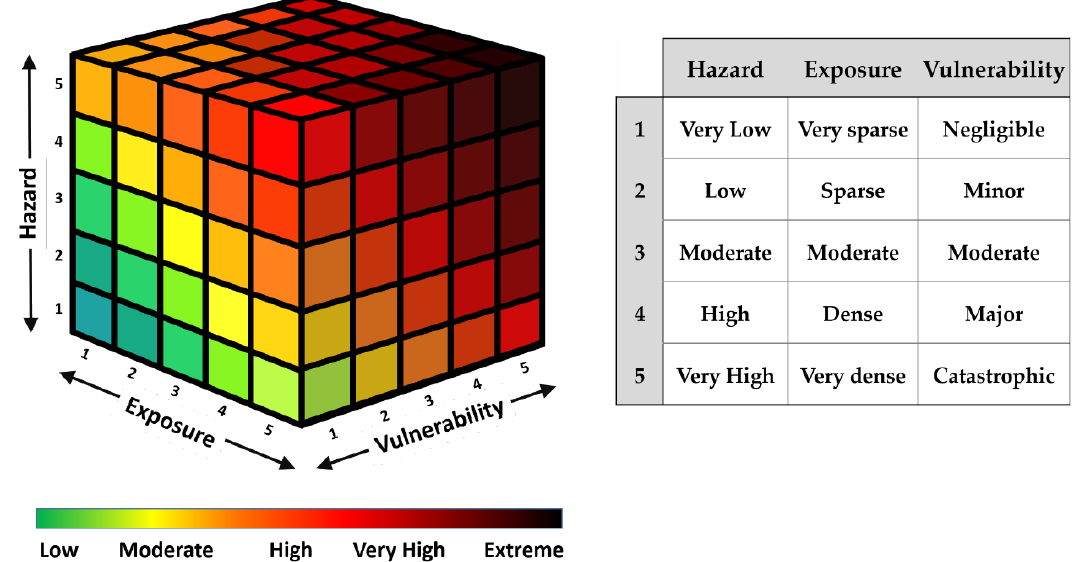
Figure 9. A schematic concept of the combination of risk components through a 3D risk matrix.